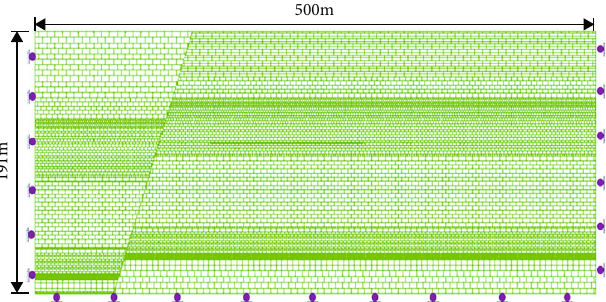
Figure 3: UDEC numerical model diagram of large mining height working face in Y.C.W coal